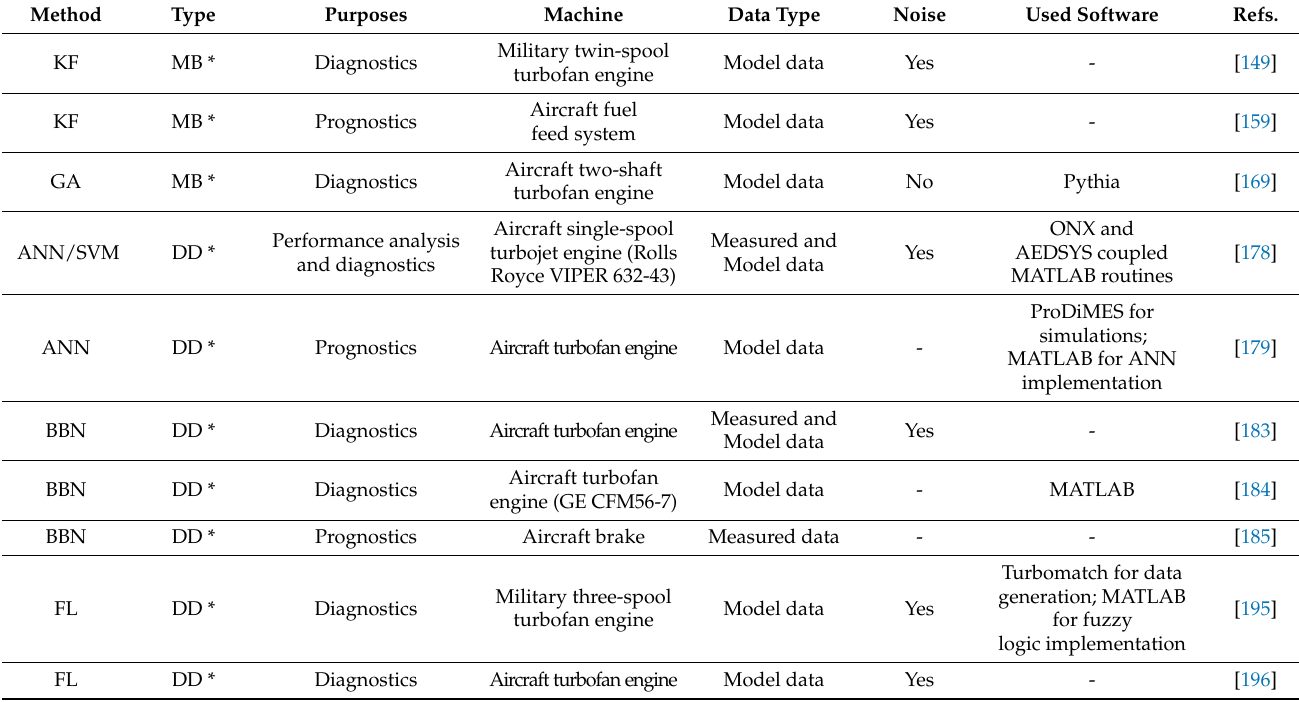
Table 7. List of some works present in the literature with relative characteristics. For a more detailed description, read the corresponding references. Continues in Table